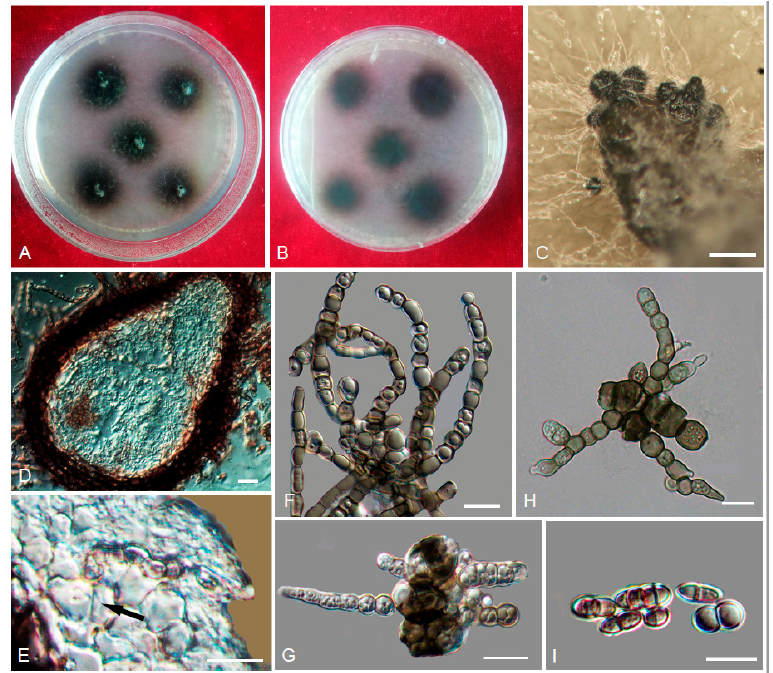
Figure 10. Knufia calcarecola (CGMCC 3.17218). ( A , B ) Colony forward and reverse after 20 weeks on MEA. ( C ) Pycnidia with hyaline surface hyphae. ( D ) Vertical section through pycnidium. ( E ) Conidiogenous cells (arrow). ( F ) Catenated, moniliform hyphae. ( G ) Multicellular bodies. ( H ) Conidia germination. ( I ) Conidia. Scale bars: ( C ) = 50 µ m, ( D ) = 5 µ m, and ( E – I ) = 10 µ